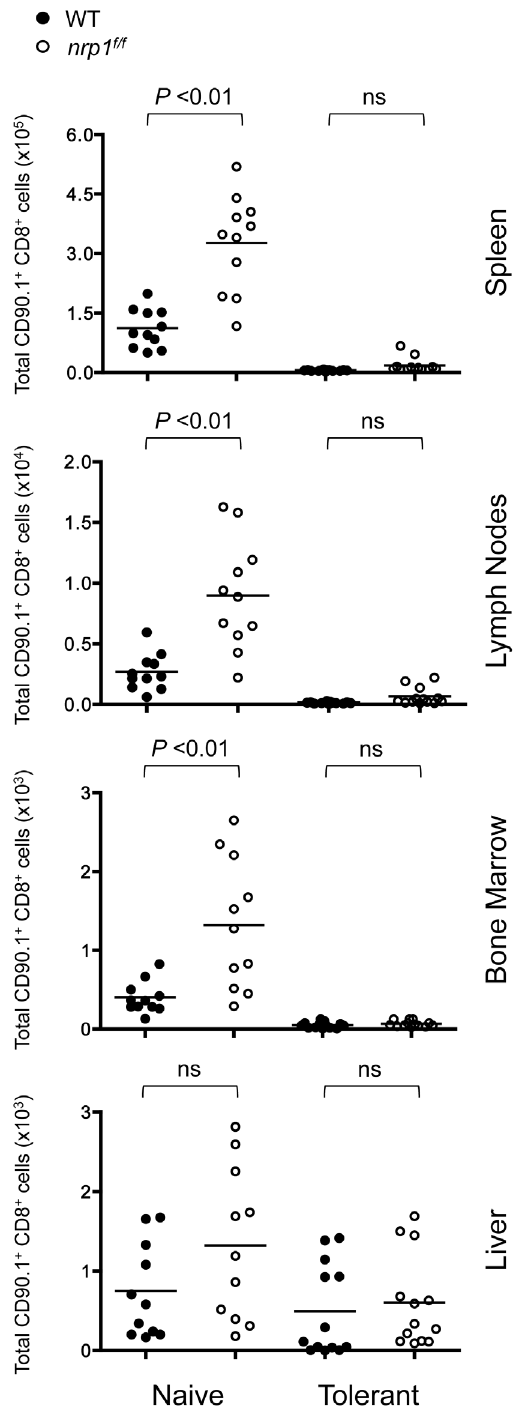
Figure 5. Deletion of self-reactive CD8 + T cells is not mediated by expression of Nrp1. Gag-specific CD8 + T cells from WT (CD90.1 + ) and Nrp1-deficient (CD90.1 + /90.2 + ) donor mice were co-transferred into B6 or Alb:Gag recipients. The frequency of transferred T cells in recipient tissues was assessed after 8 days. The total number of WT or Nrp1- deficinet T cells in the indicated tissue is displayed graphically and shows pooled data from 4 independent experiments, with each circle representing data from one mouse. Horizontal bars represent the average for each group and P values are indicated (ns = not significant).